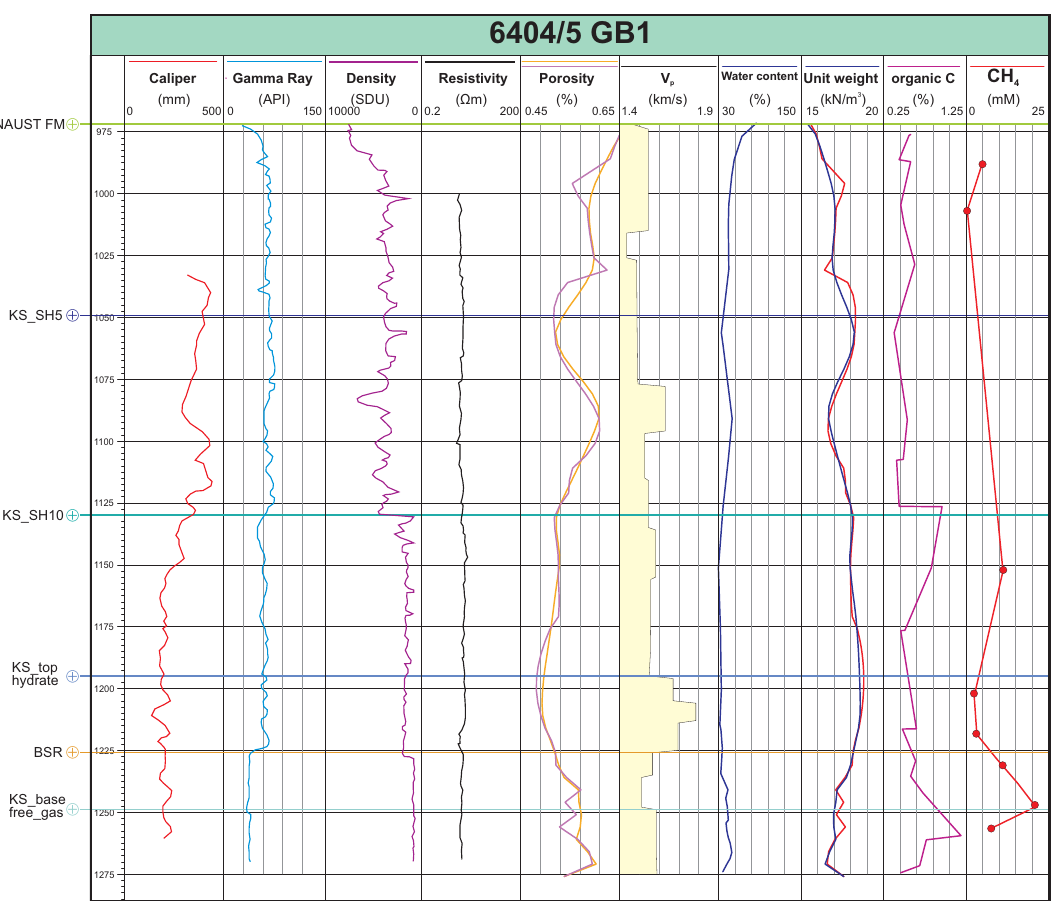
Wireline and measured data from the 6404/GB5 geotechnical borehole.